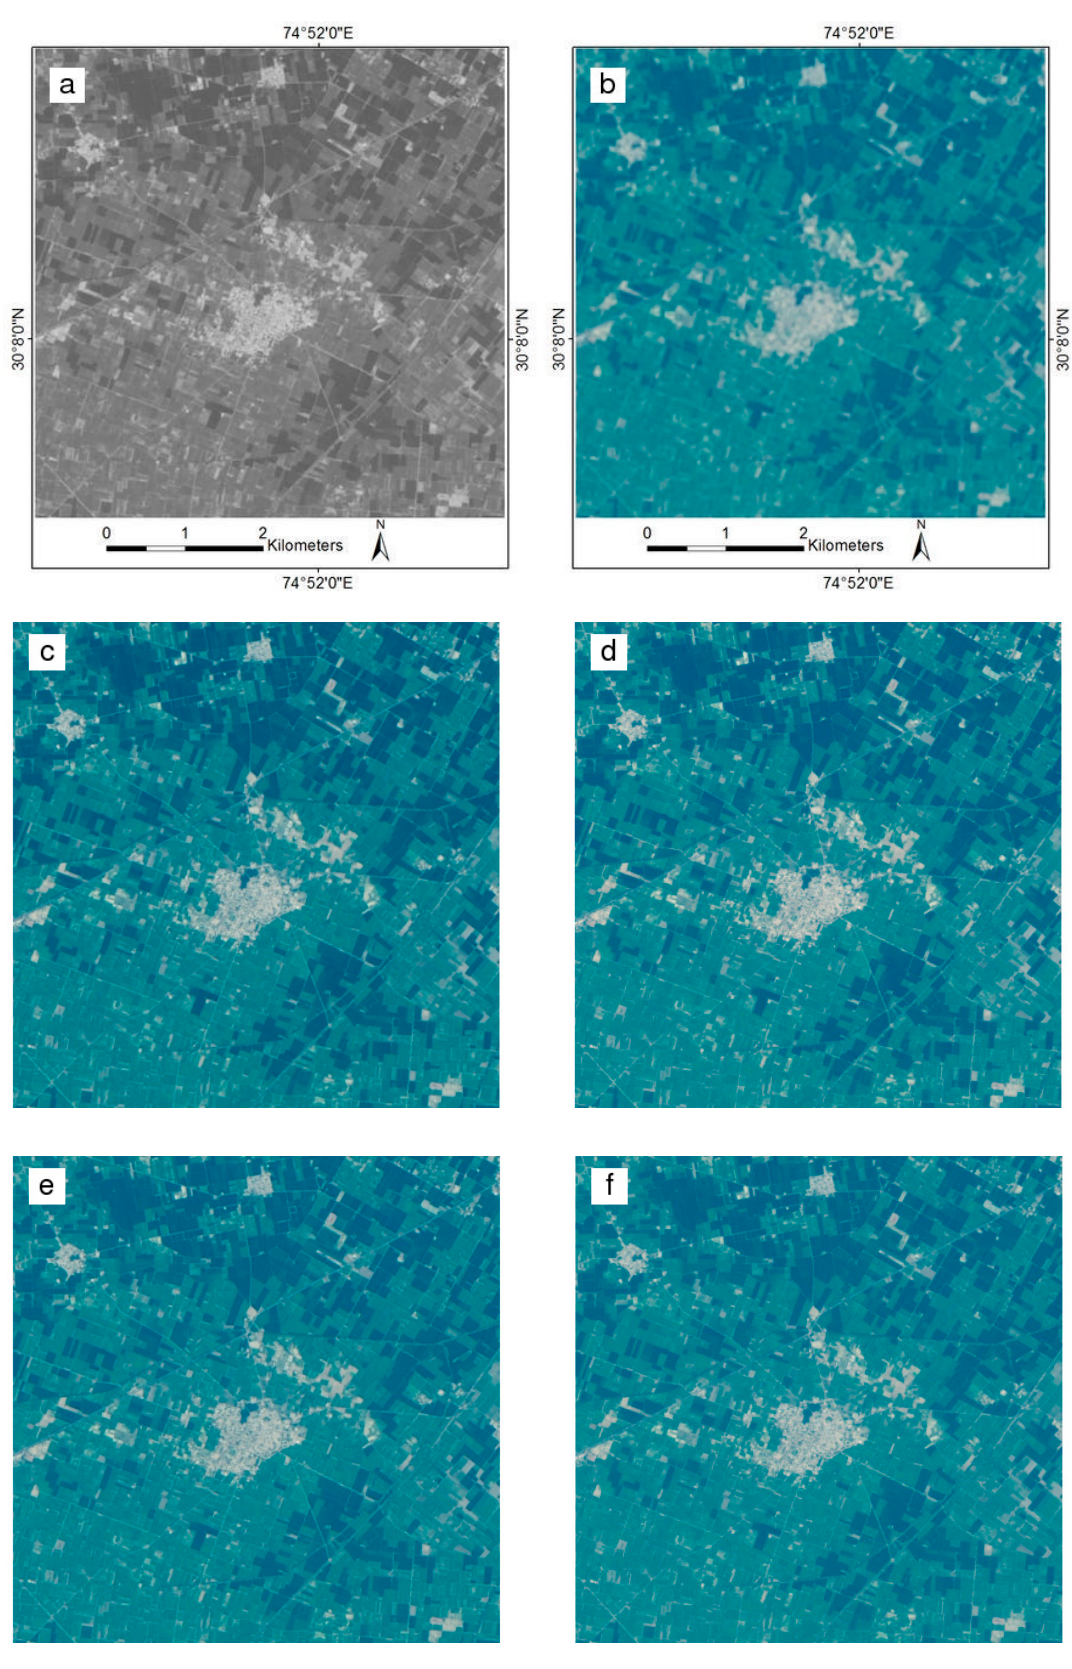
Figure 8. Cont. Figure 8.